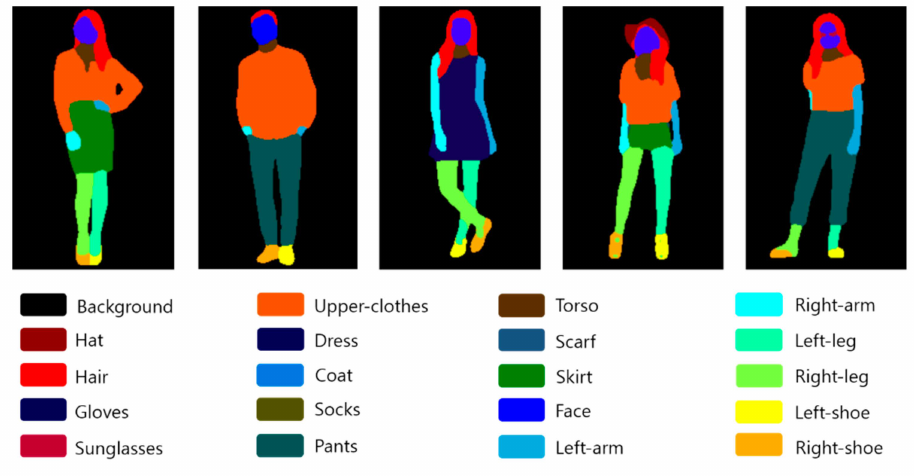
Figure 3. Segmentation images and labels by color used in the experiment.